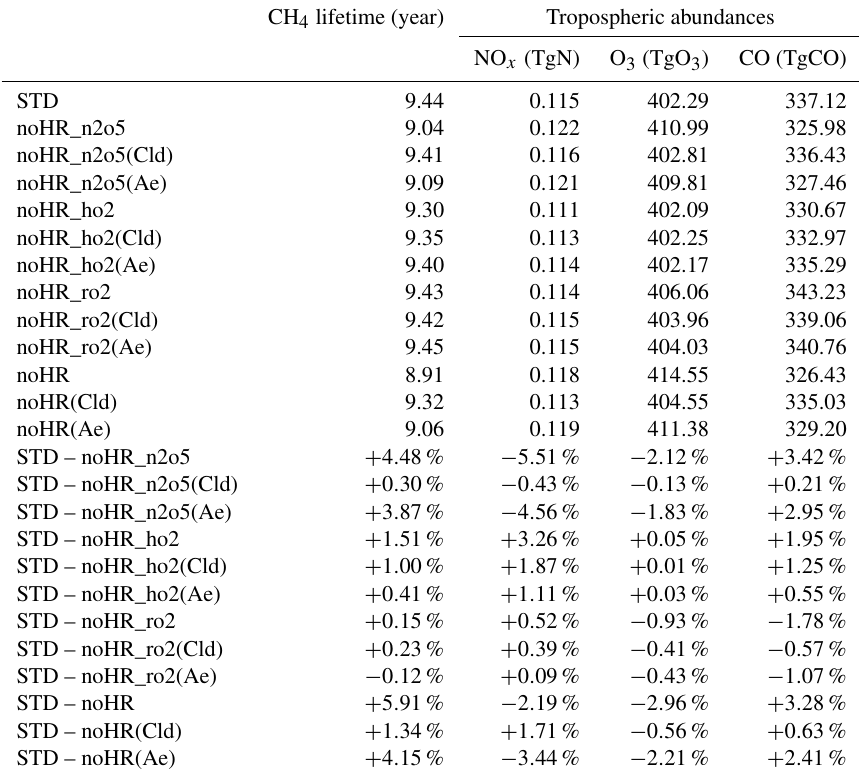
Table 9. Tropospheric abundances changes by HR(N 2 O 5 ), HR(HO 2 ), HR(RO 2 ), and all HRs for clouds and